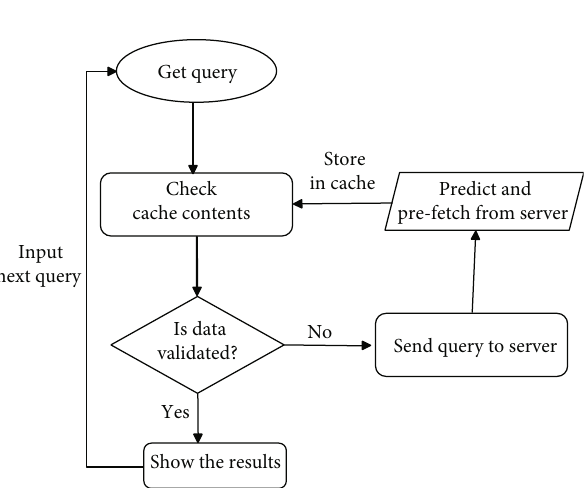
Figure 3: Flowchart of the proposed